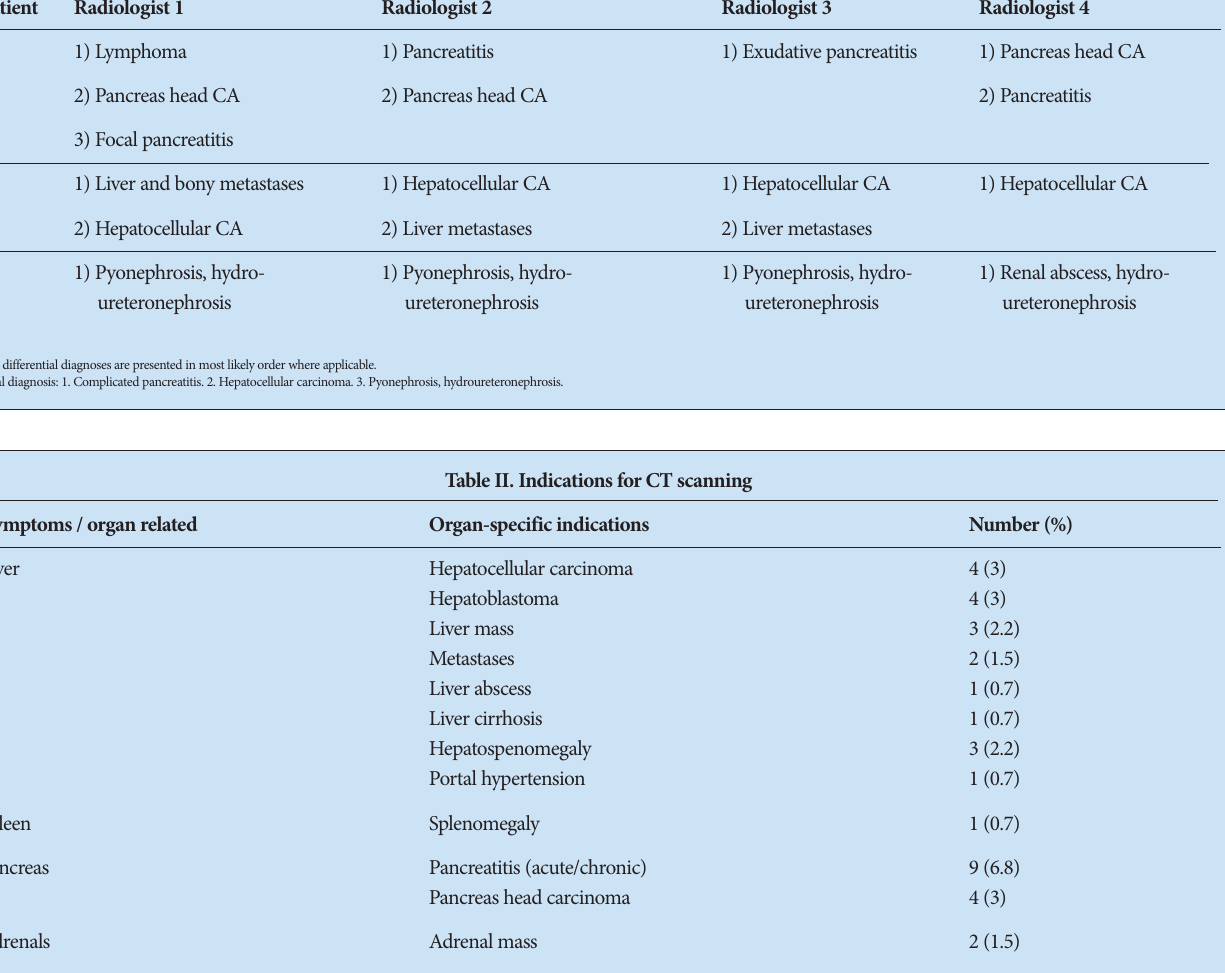
Table I. Results of independent radiologist review